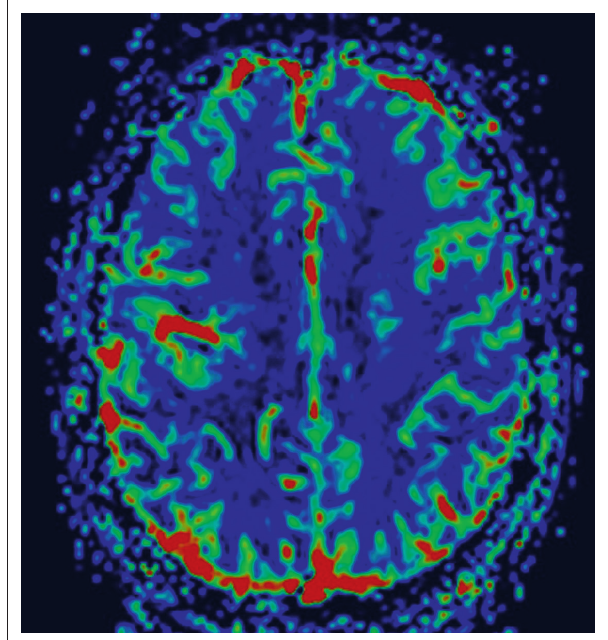
FIGURE 6: Axial rCBV MR Perfusion image.